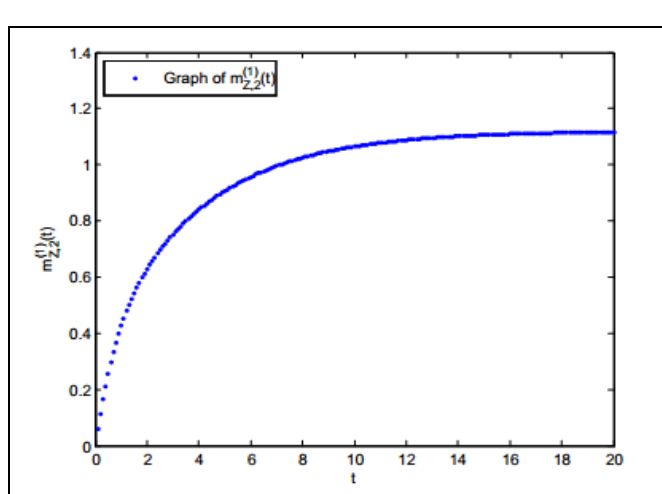
Figure 3. Graph of 𝑚 𝑍,2(1)